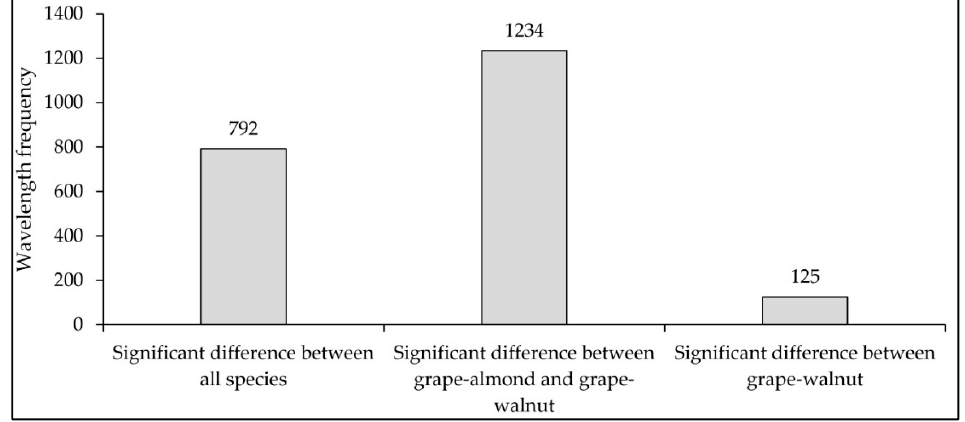
Figure 2. Frequency of wavelengths that have the potential for separating walnut, almond, and grape species at the leaf surface in accordance with the ANOVA test (Vertical axis: wavelengths frequency and horizontal axis: wavelengths and status).